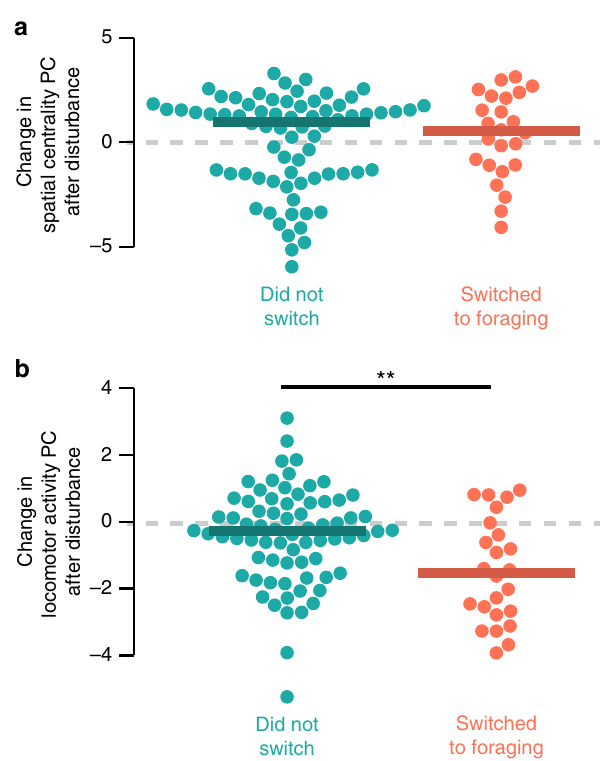
Fig. 8 Initiating foraging decreases locomotor activity within the nest. Beeswarm plots of change in nest behavior metrics after disturbance by foraging status after disturbance, among bees that had performed no foraging before disturbance. a Change in spatial centrality (PC1) scores, and b change in locomotor activity scores (PC2). Points show mean values for individual bees during the three days after disturbance, and thick lines show median values for group. ** p < 0.005 in a linear mixed-effects